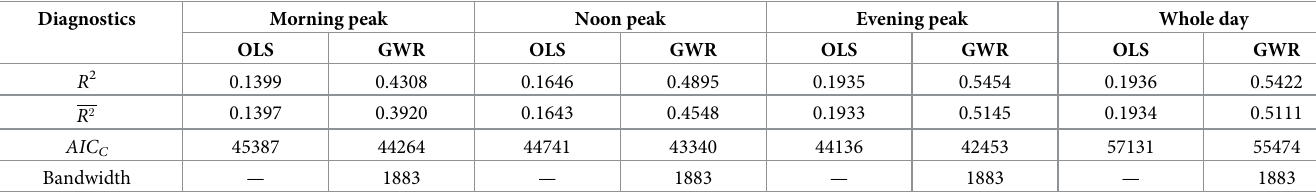
Table 4. Comparison results of the OLS and the GWR model on weekdays.